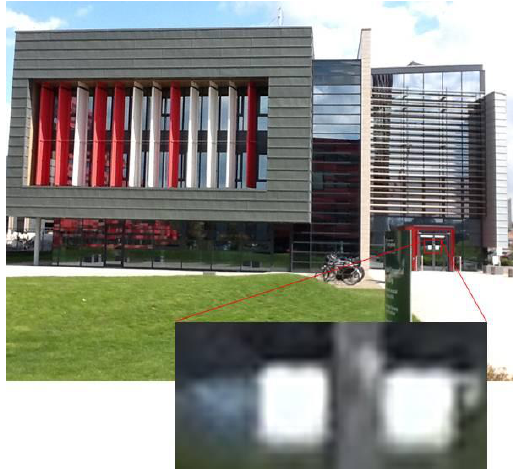
Figure 10. Building facade and image quality from the iPad 2